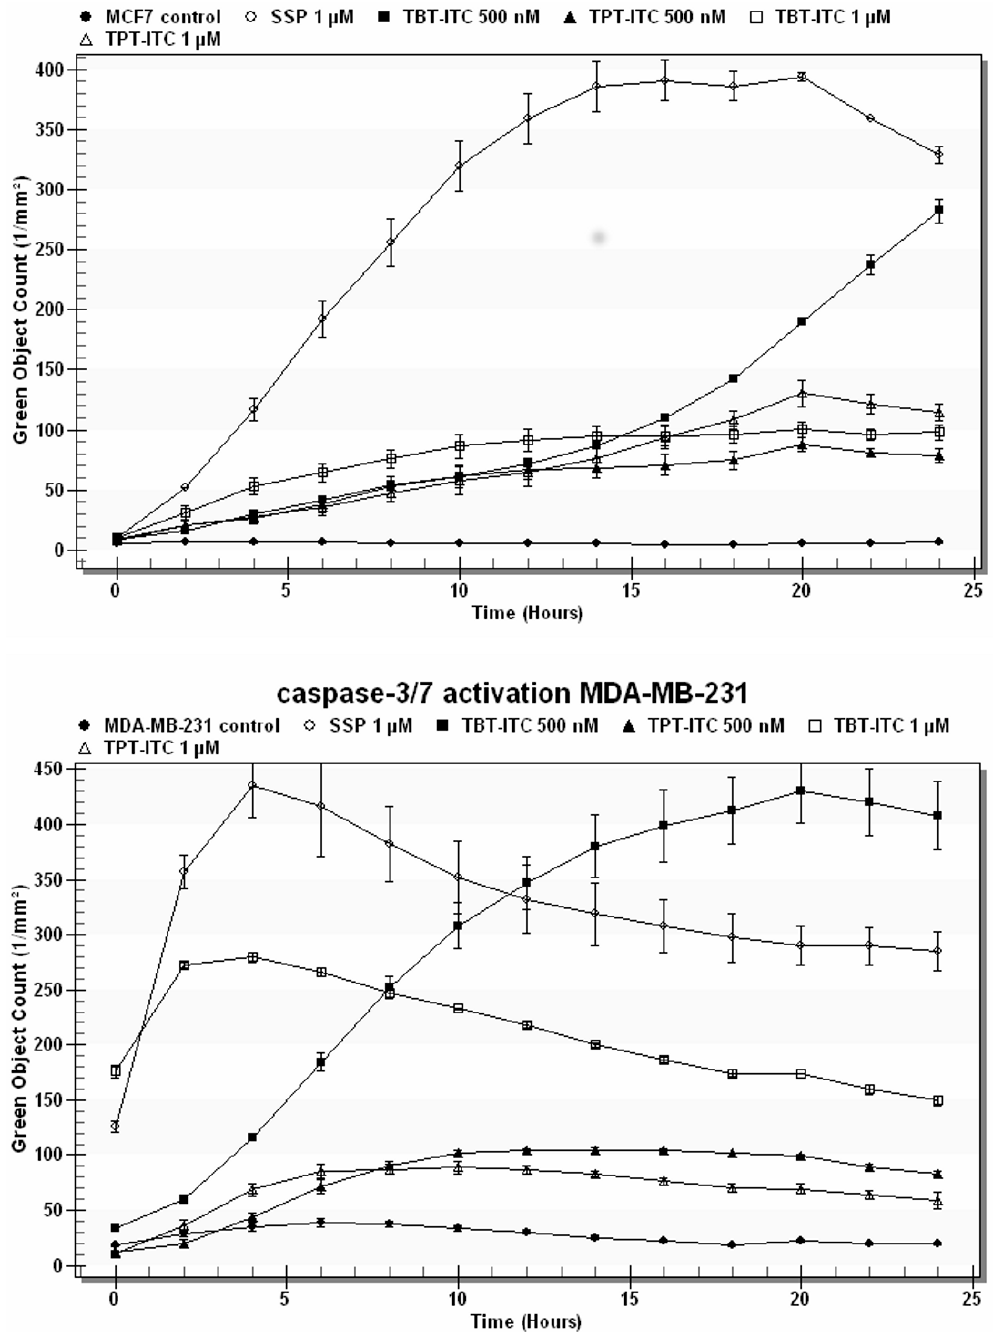
Figure 6. Caspase-3/7 activation in human breast cancer cells. Caspase-3/7-positive objects stained by CellPlayer™ Kinetic Caspase-3/7 Apoptosis Assay Reagent were measured over 24 h in response to increasing concentrations of TBT-ITC and TPT-ITC derivatives. SSP (1 μ M) was used as a positive